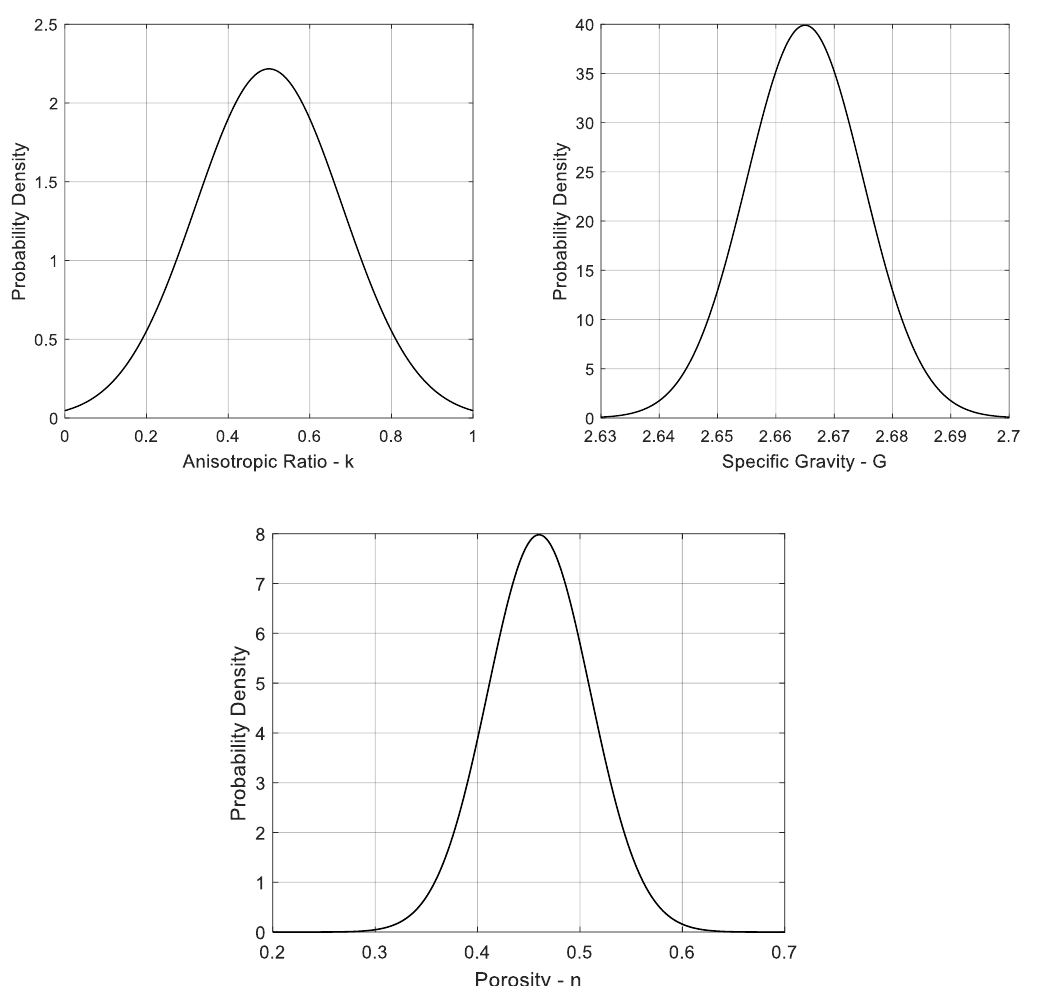
Fig. 8 . Distributions of the random variables used to evaluate fragility